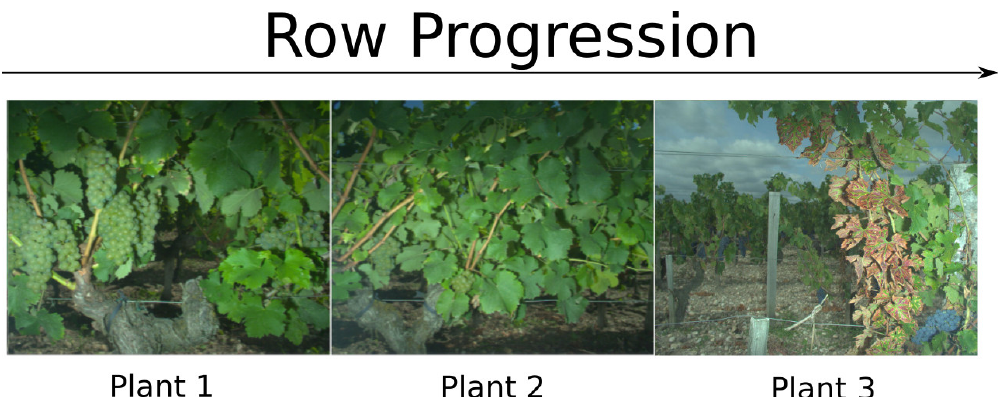
Figure 4. Examples of pictures acquired in a